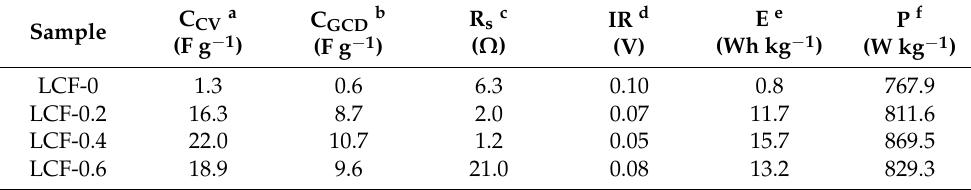
Table 4. Summarized supercapacitor performance using different LCF electrodes.